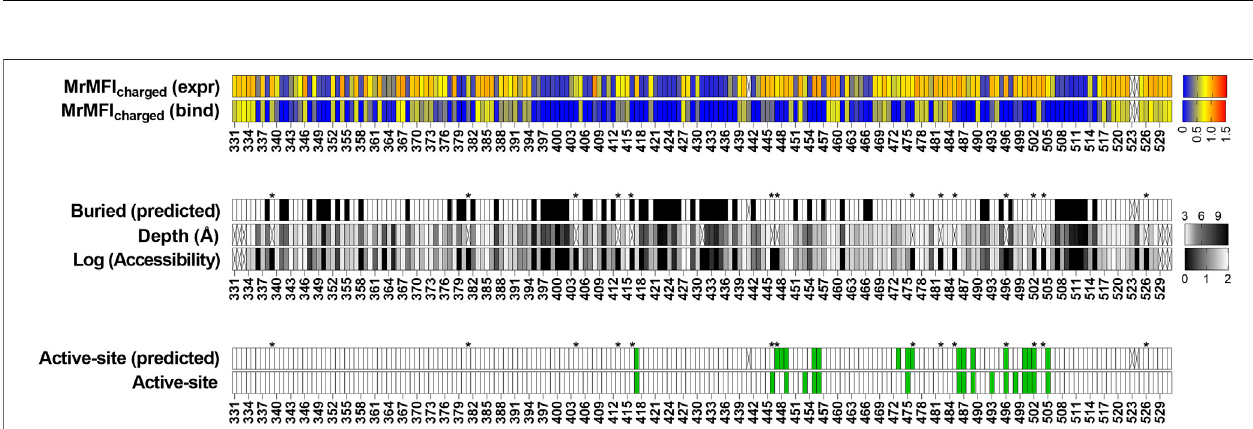
FIGURE 6 | Comparison of stabilities estimated by DeepDDG and yeast surface display. Heat maps for (A,C) MFI seq (bind) normalized to WT and (B,D) ΔΔ G predicted by DeepDDG. Residue positions or speci fi c amino acid mutations showing signi fi cantly different predicted stabilities by the two methods are highlighted by a box. Blue to red colour corresponds to increasing stability.